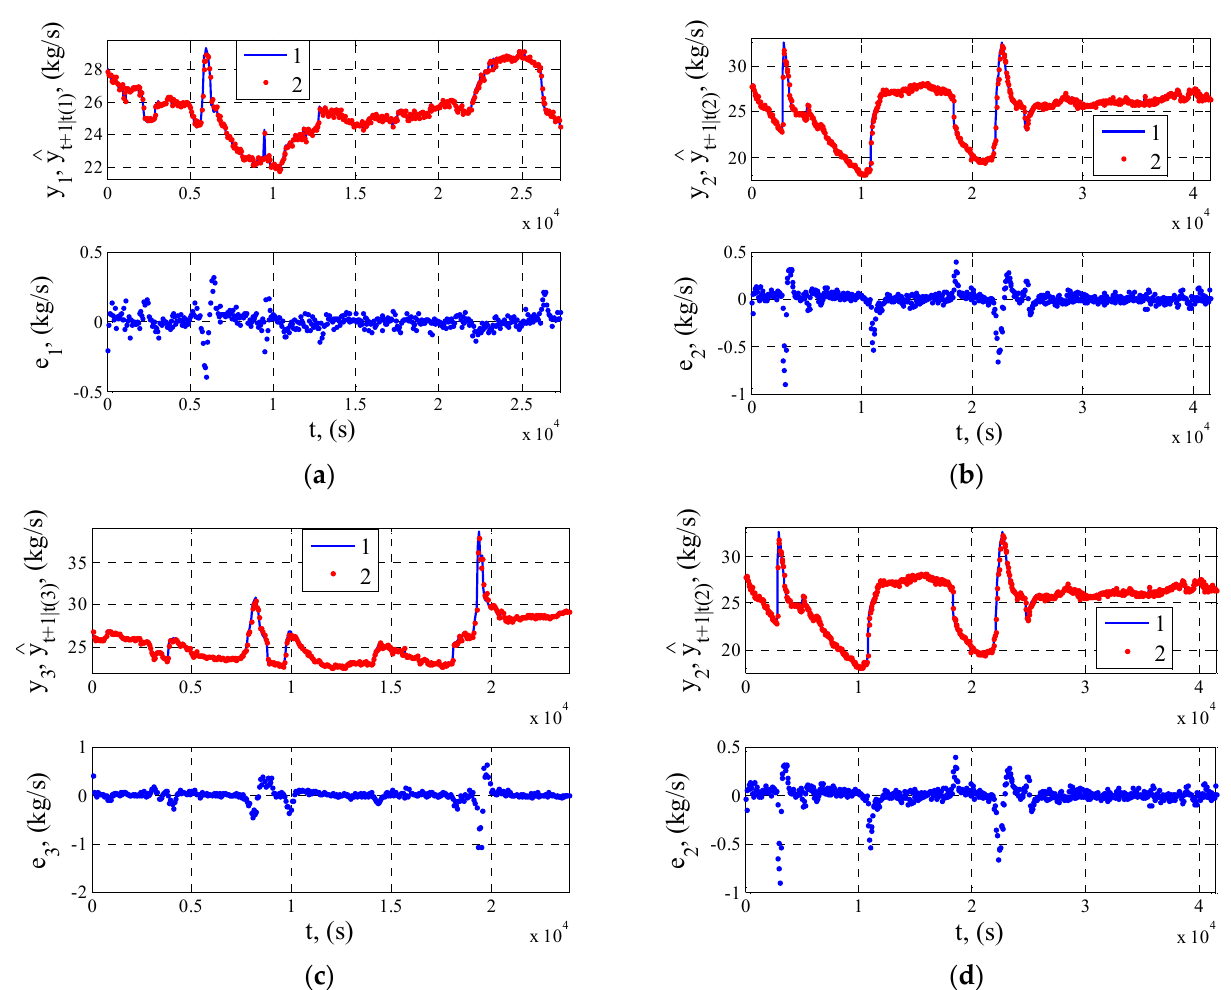
Figure 11. Prediction error and one-step forecast of the flotation feed solids flow rate against measured data; ( a ) series 1, ( b ) series 2, ( c ) series 3, ( d ) series 4; 1—measured data, 2—forecast.